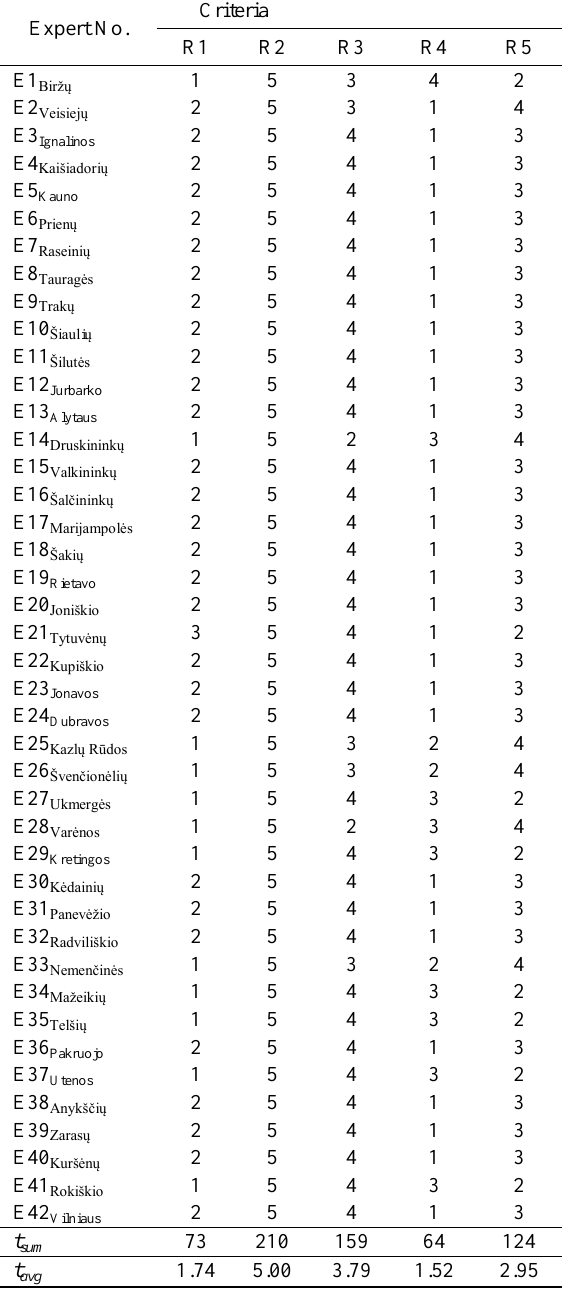
Table 2. Results of experts’ questioning Expert